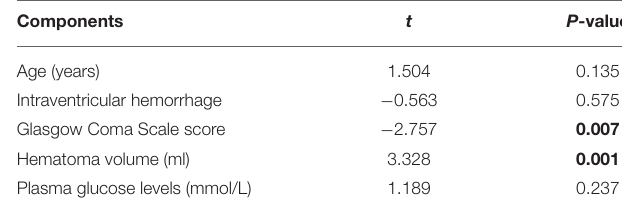
TABLE 4 | Multivariate linear regression analysis of elevated plasma cellular prion protein